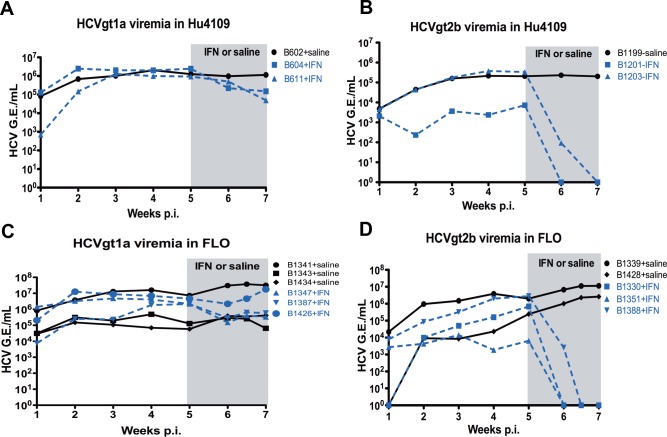
Effect of the poor-responder genotypes of IL28B/IFNL4 SNPs on HCV responses to IFNα in mice.We infected chimeric mice populated with human hepatocytes from two donors, Hu4109 (A, B) and FLO (C, D), with HCVgt1a (A, C) or HCVgt2b (B, D). We administered exogenous human IFNα-2b for 14 days starting at 5 weeks post-infection. We administered saline to control chimeric mice on the same schedule. We collected sera weekly to measure viremia. Results for mice treated with saline are represented by black solid lines and data for mice treated with human IFNα are represented by blue dashed lines. The period of IFNα/saline treatment is shaded in gray.